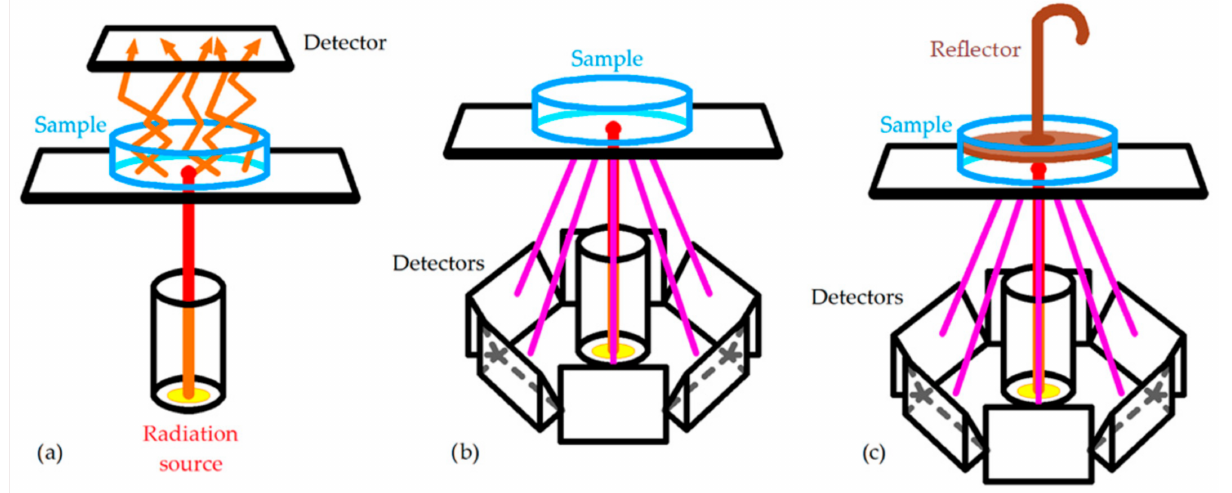
Figure 1. Main configurations to acquire NIR spectra: ( a ) transmittance; ( b ) reflectance; ( c ) transflectance